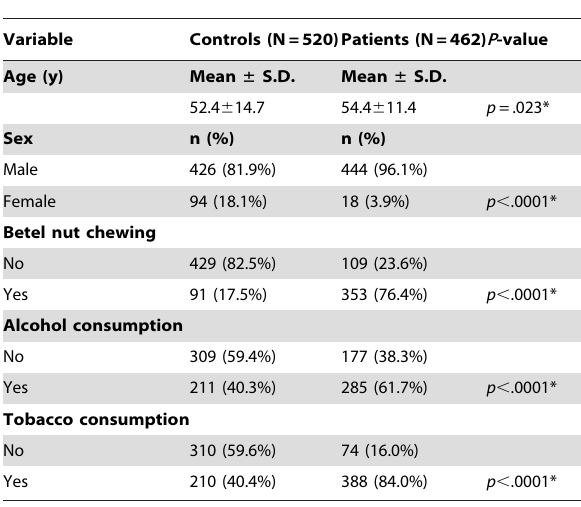
Table 1. Distributions of demographic characteristics in 520 controls and 462 patients with oral